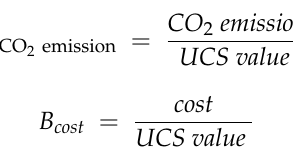
Figure 14. Plot of Al / Ca atomic ratio vs. Si / Ca atomic ratio of ( a ) SC100; ( b ) SCA0—SCA15 and ( c ) SCC5—SCC15 samples .